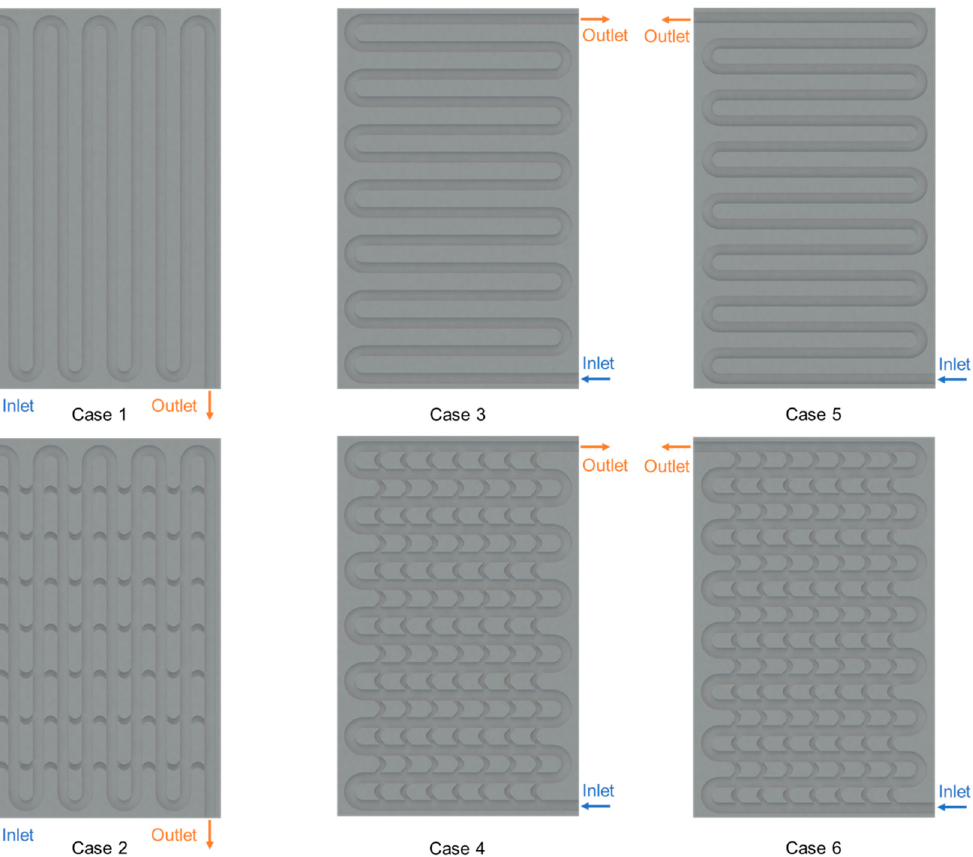
Figure 2. Schematics of the flow channel designs investigated in the present study. Cases 1-3 are channel designs without intersecting branches while Cases 4-6 are with V-shaped intersecting branches. Table 2. Parameter values for the flow channels within the cold plate.